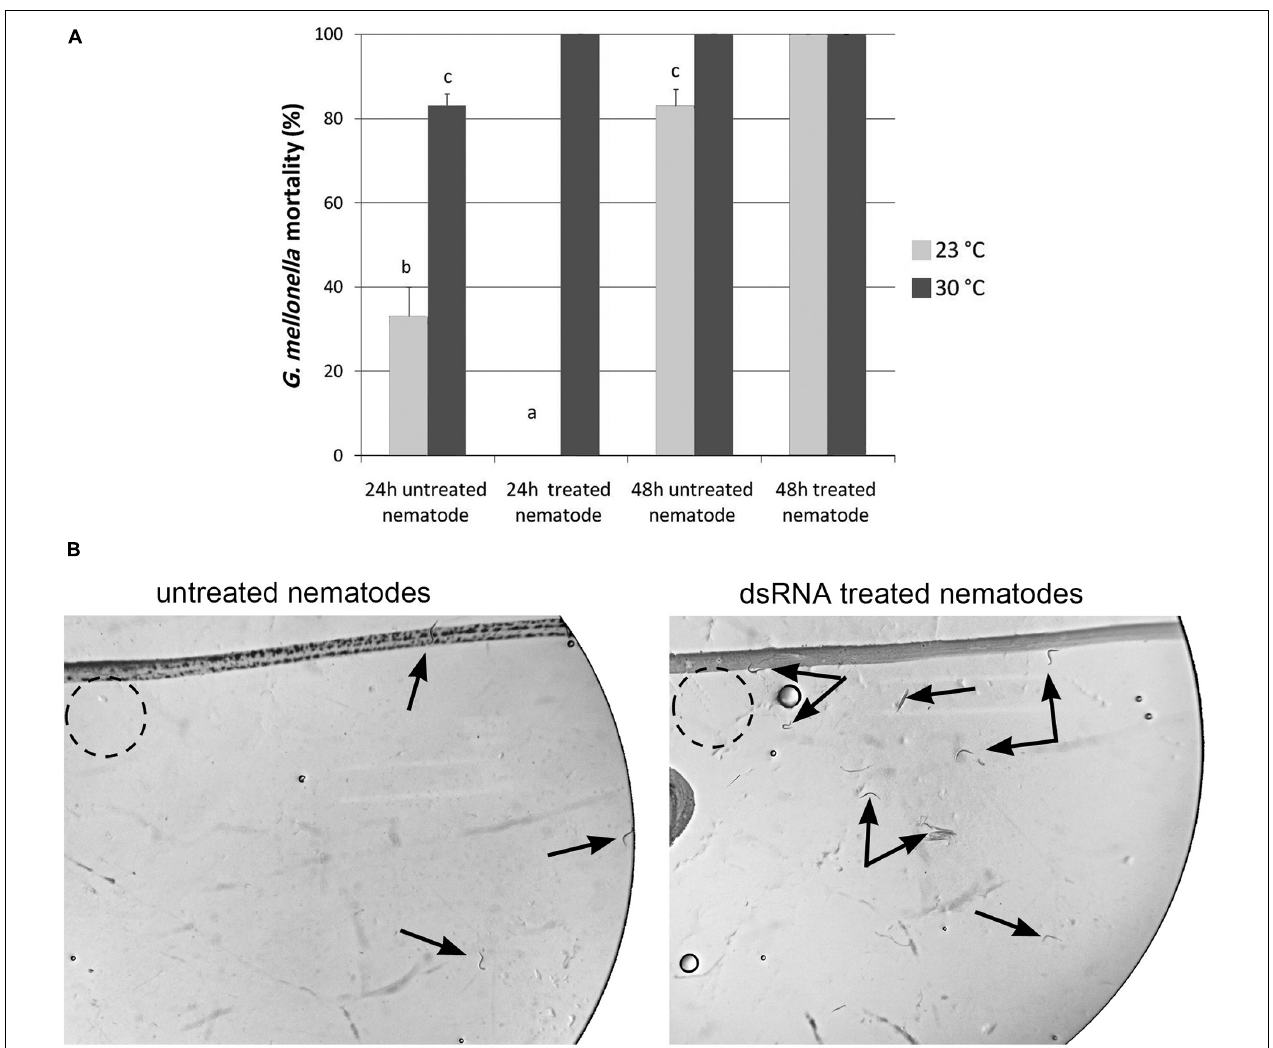
FIGURE 9 | Mean percentage mortality of Galleria mellonella larvae after 24 and 48 h following exposure to dsRNA treated Infective Juveniles (IJs) and untreated Infective Juveniles at 23 and 30 ◦ C (A) . Different letters above bars indicate statistical differences. Untreated and silenced Infective Juveniles (IJs) were transferred on Petri dishes, containing water agar layer, in presence of Galleria mellonella larvae to assess nematode attraction (B)